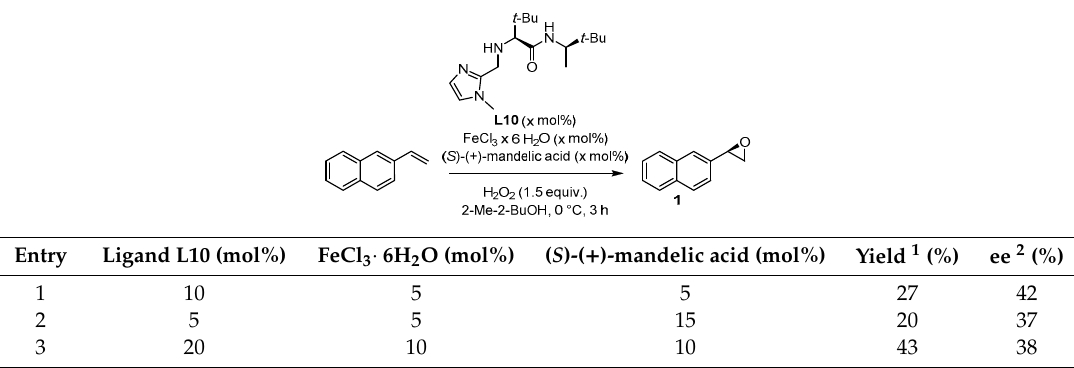
Table 2. Screening of